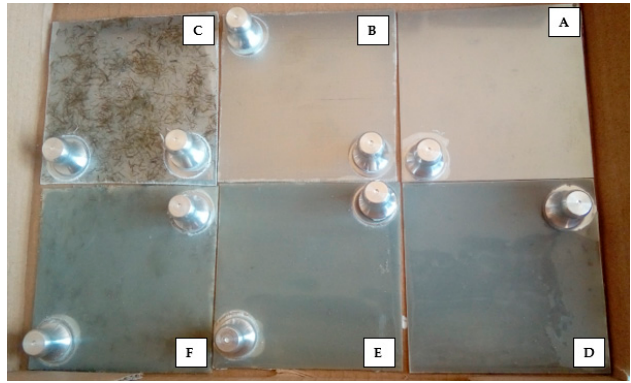
Figure 3. Samples prepared for adhesion testing, A—EP; B—EP_GF; C—EP_GF_HF; D—EP_PUA; E—EP_GF_PUA; F—EP_GF_HF_PUA. Table 6. Pull-off test classification according to the norm PN–EN ISO 4624:2016 [25].